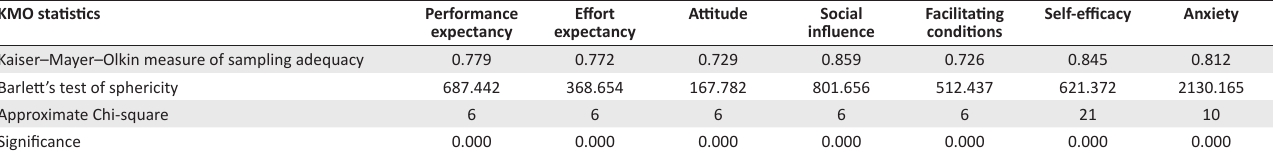
TABLE 1: Kaiser–Mayer–Olkin statistics for all unified theory of acceptance and utilisation of technology factors. KMO